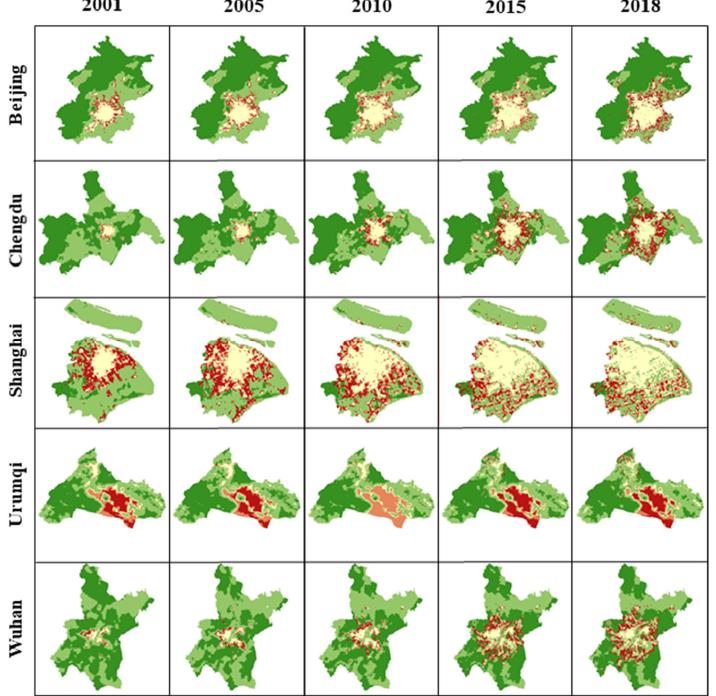
Figure 6. The CCD change in five selected cities (Beijing, Chengdu, Shanghai, Urumqi, and Wuhan).